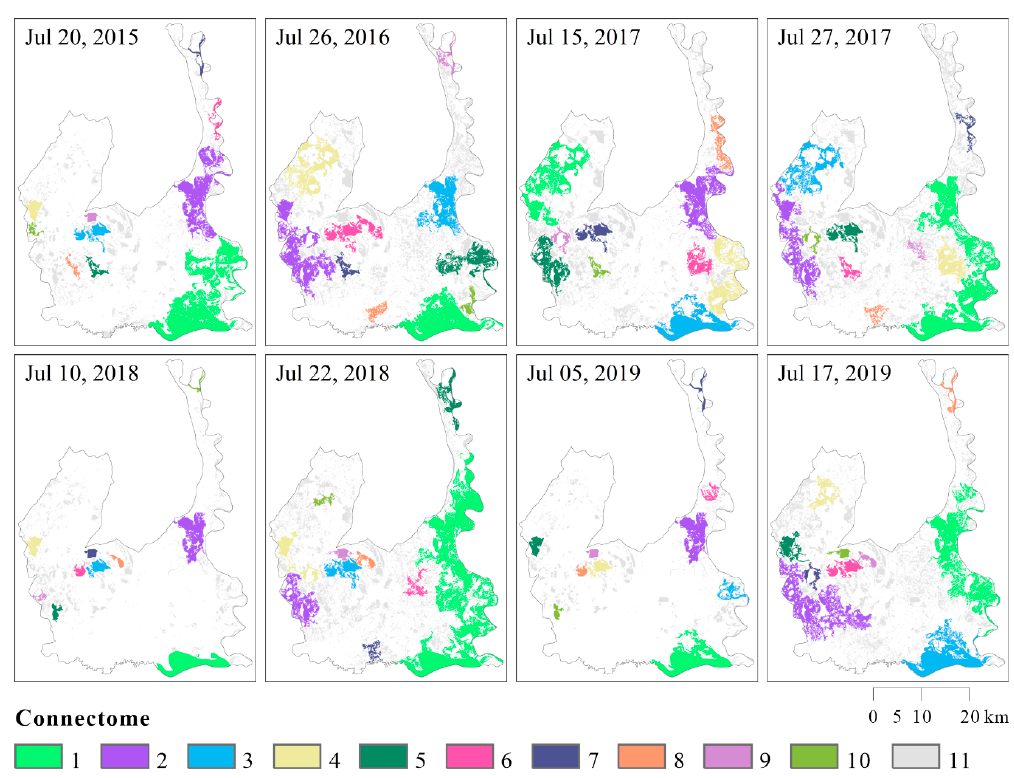
Figure 11. Spatial distribution of the connectomes (i.e., seasonally connected water bodies) in China’s Momoge National Nature Reserve in July. Colors 1 to 10 in the legend refer to the top ten largest connectomes, and color 11 refer to the remaining connectomes and isolated water bodies.